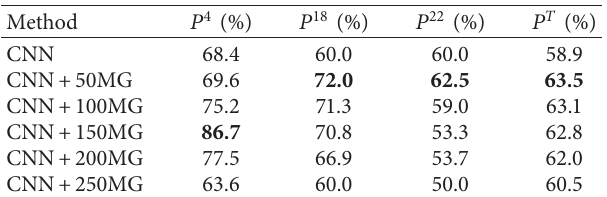
p . Table 2: Accuracy of chromosome classification on the collected dataset with several comparative